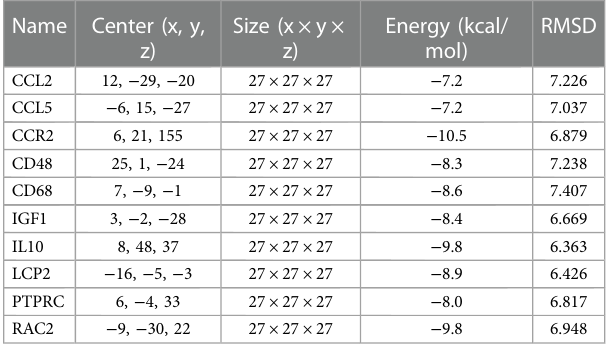
TABLE 2 Molecular docking results of sirolimus and 10-hub